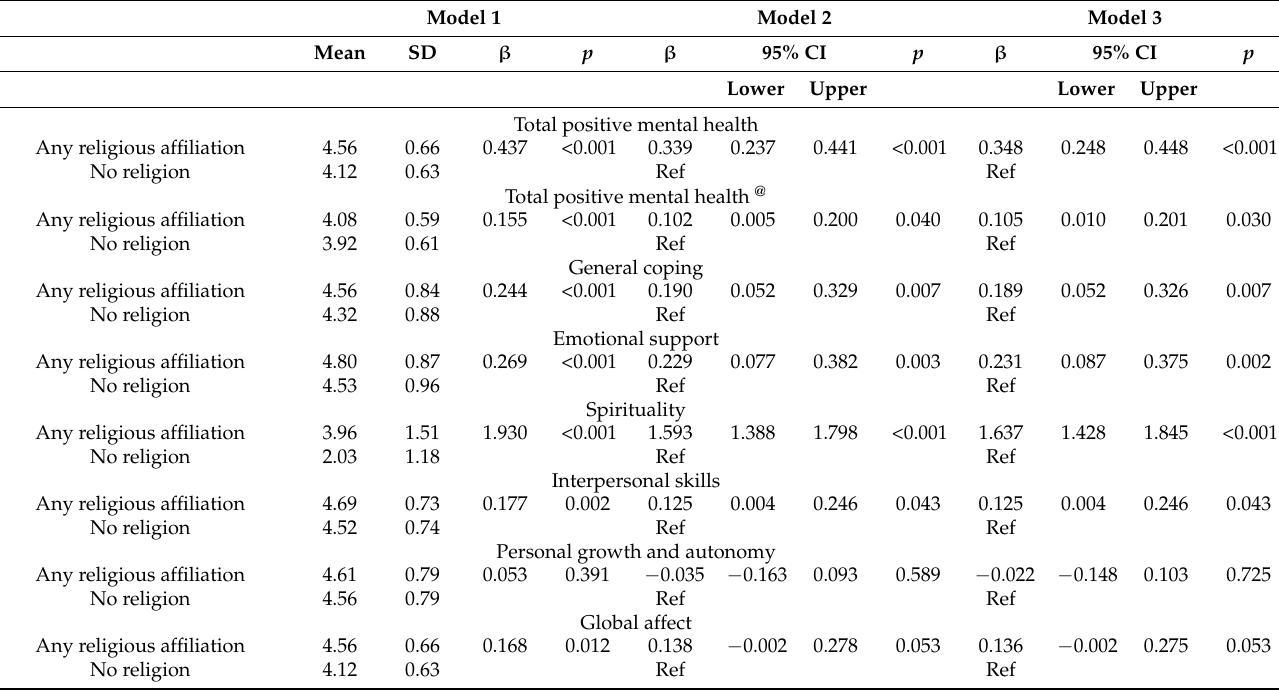
Table 2. Association between having any religious affiliation and total positive mental health and its subcomponents.